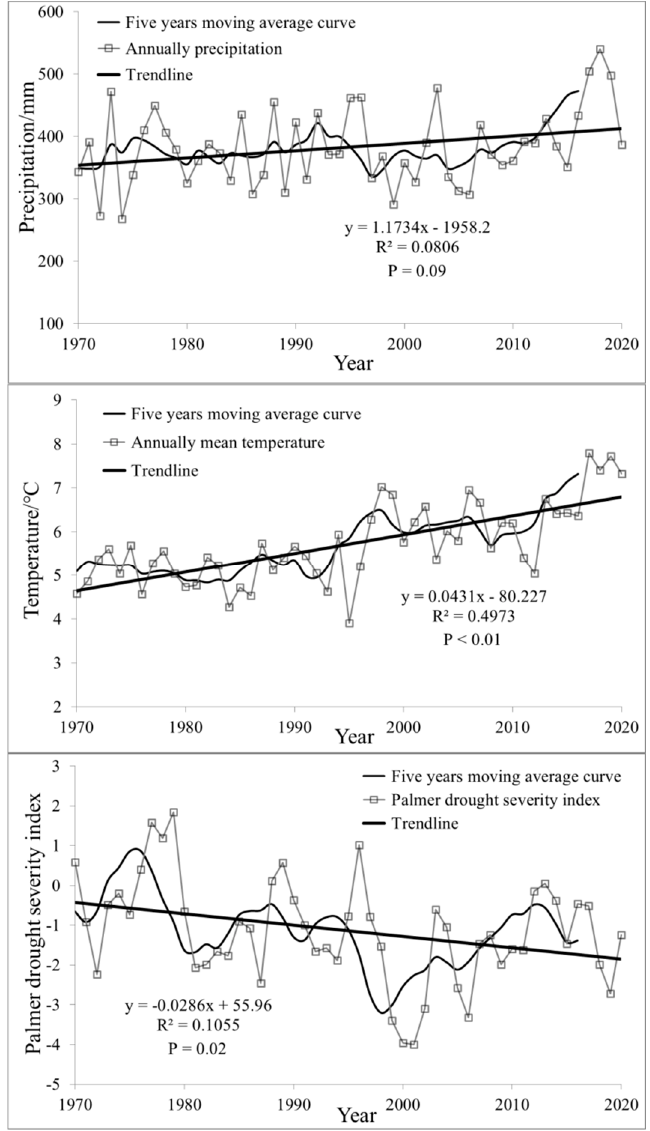
Figure 4. Annual change trends of precipitation and average temperature at 4 meteorological sta- tions and the PDSI values near the sampling points from 1970 to 2020. and the PDSI values near the sampling points from 1970 to